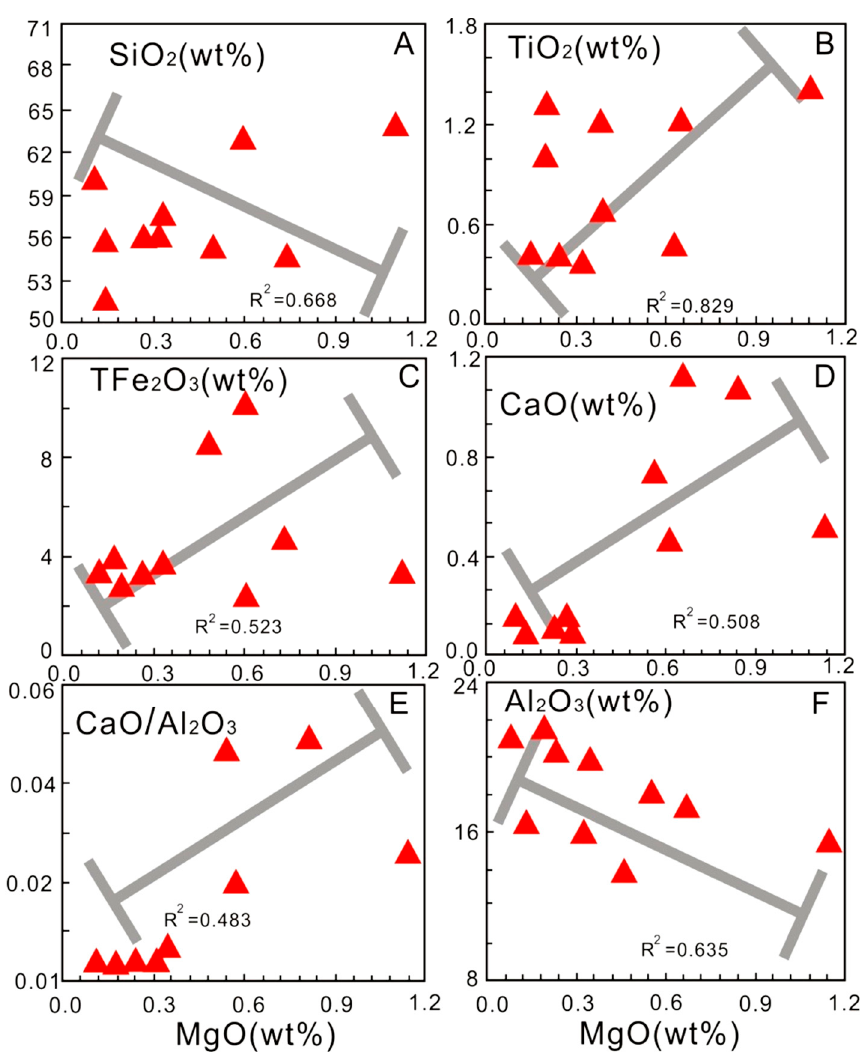
Figure 10. Selected elements vs. MgO diagrams ( A ) SiO 2 , ( B ) TiO 2 , ( C ) TFe 2 O 3 , ( D ) CaO, ( E ) CaO/Al 2 O 3 , ( F ) Al 2 O 3 . Note: red Δ represents syenite samples.